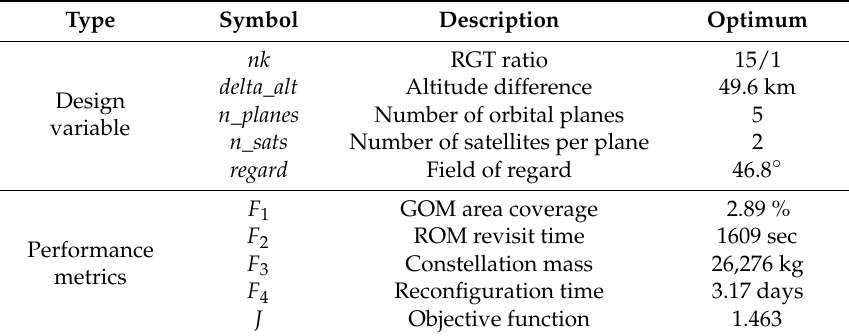
Table 14. SA optimal solution (5